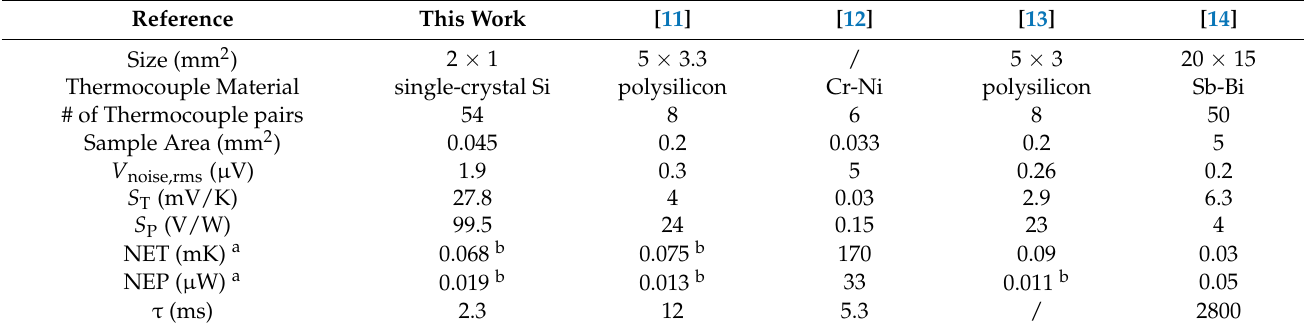
Table 2. Comparison of MEMS differential thermopiles for thermal analysis of